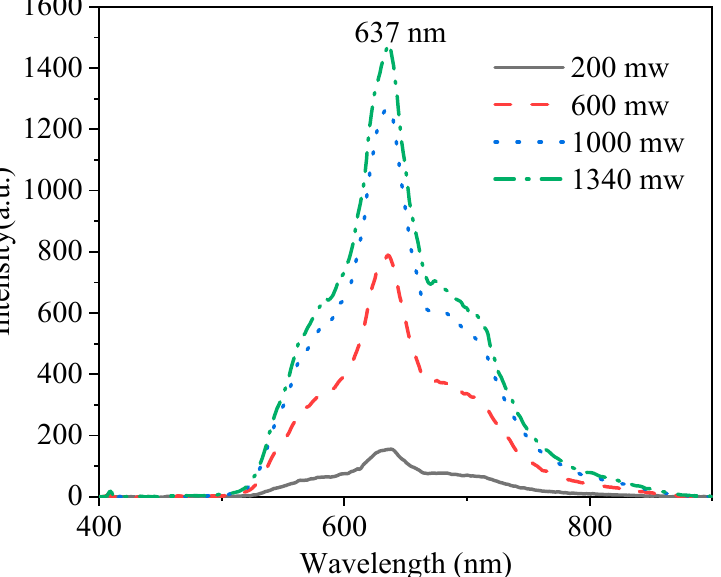
Figure 12. Emission spectra of the Yb 2+ -doped silica fiber as a function of pump power at an excitation of 405 nm.